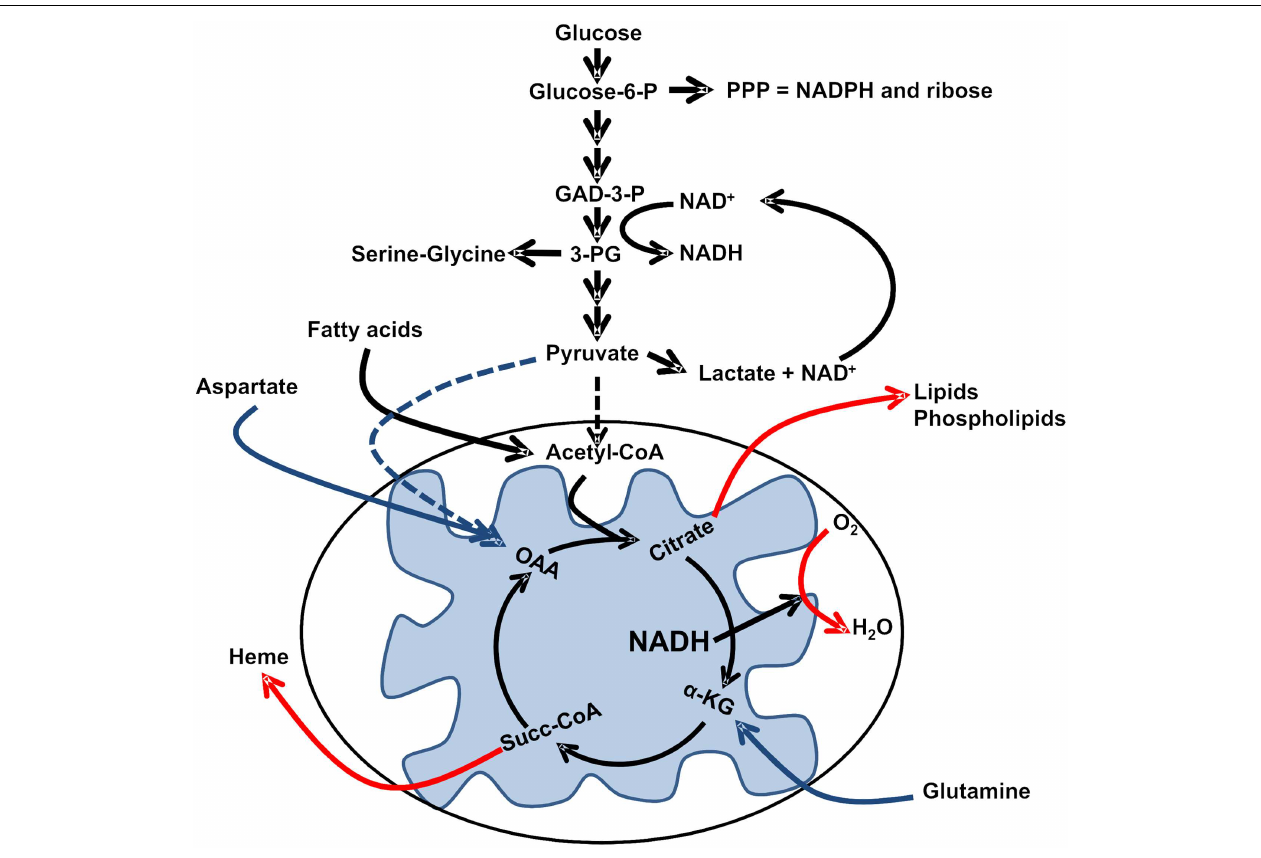
(3-PG). In order to maintain an adequate supply of biosynthetic intermediates in the absence of pyruvate-derived oxaloacetate (OAA), Krebs cycle activity relies on glutamine anaplerosis to regenerate alpha-ketoglutarate ( α -KG; and potentially aspartate anaplerosis). Regeneration of cataplerotic citrate also relies on FAO-derived acetyl-CoA. Please refer to the text for additional